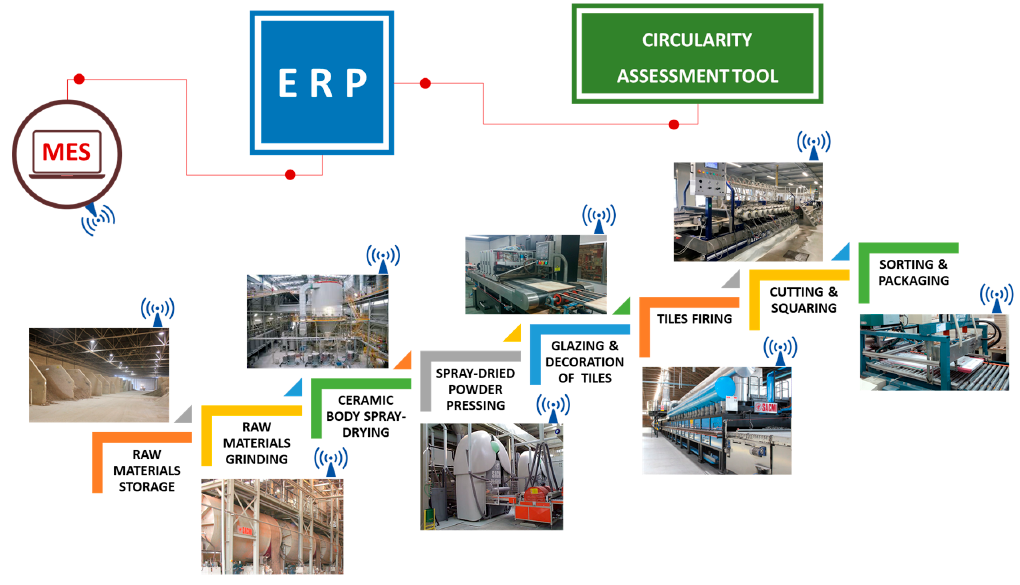
Figure 3. Ceramic production process layout with smart data collection system scheme.